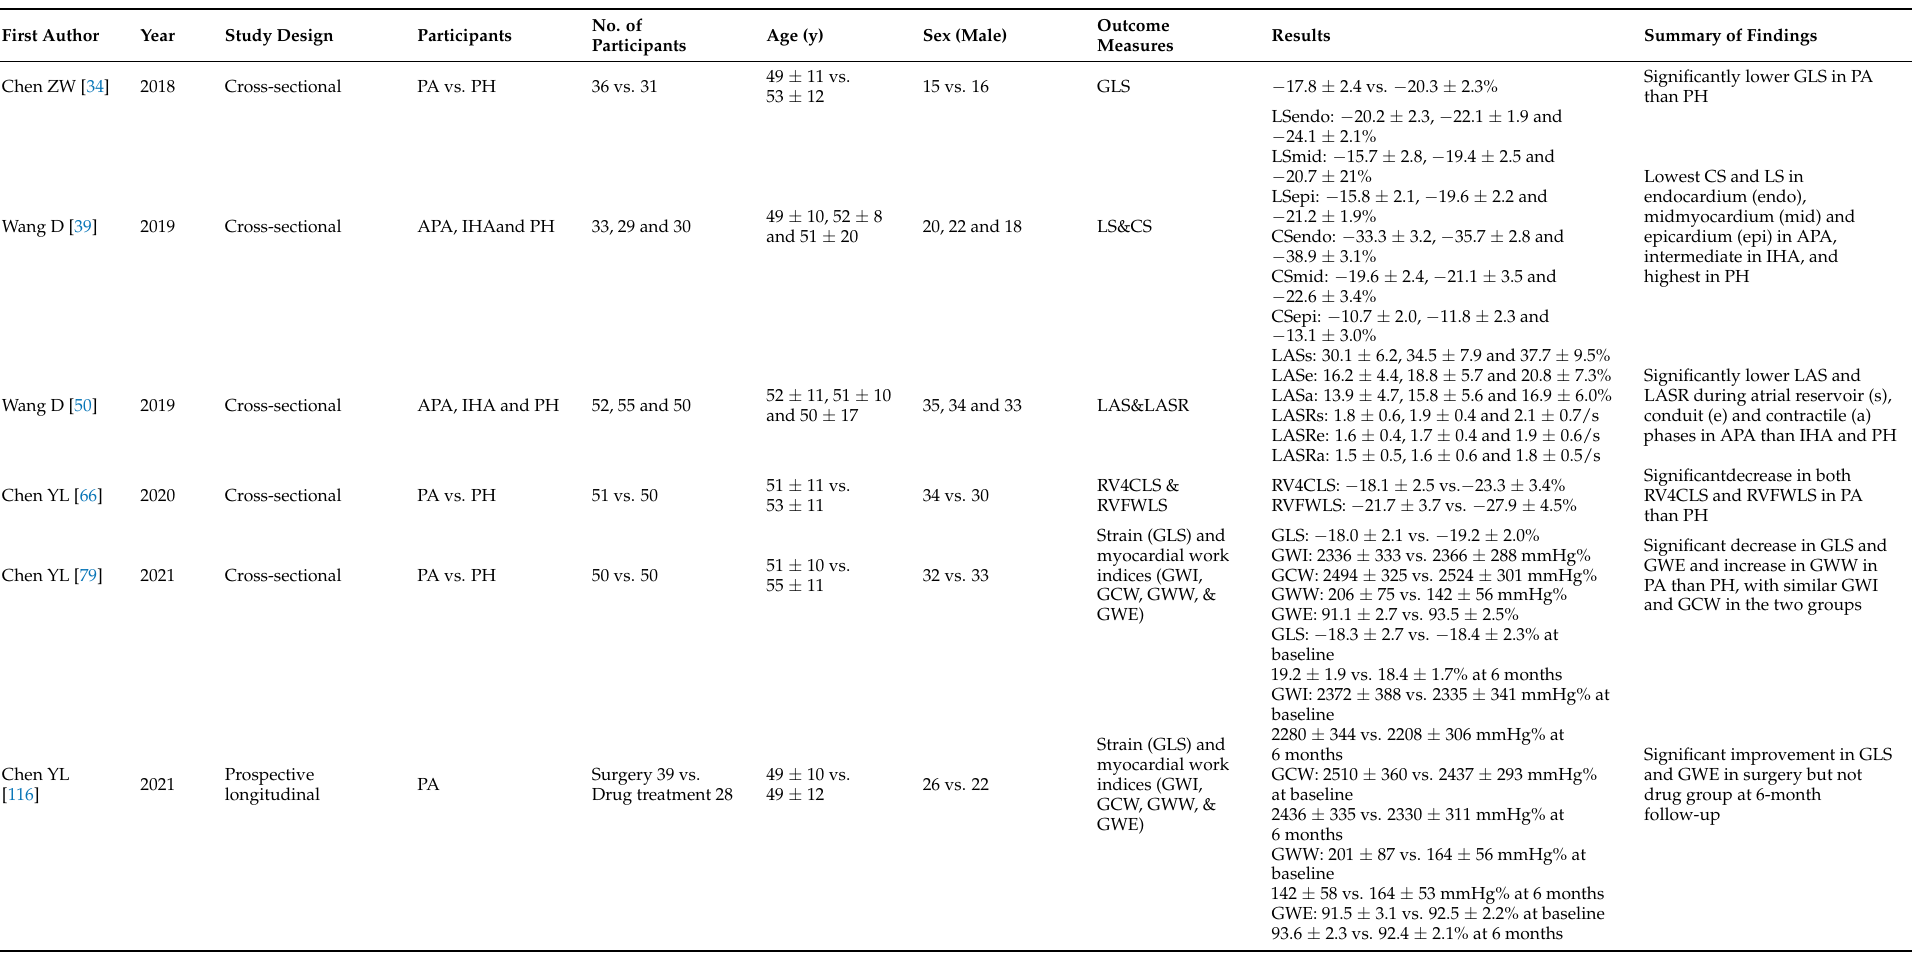
Table 2. Summary of main imaging studies with speckle tracking echocardiography on primary